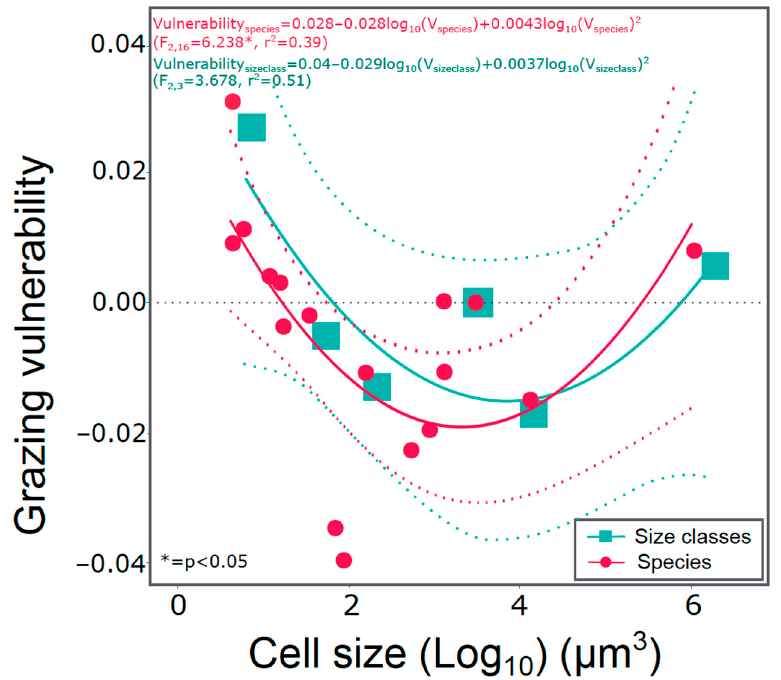
Figure 2. Grazing vulnerability as a function of mean cell size of size classes (green color data) and of different species (red color data). Grazing vulnerability calculated as regression slope of cell abundance in response to copepod density (see also Figures S3 and S4 in Supporting Information). Dashed lines represent 95% confidence intervals.